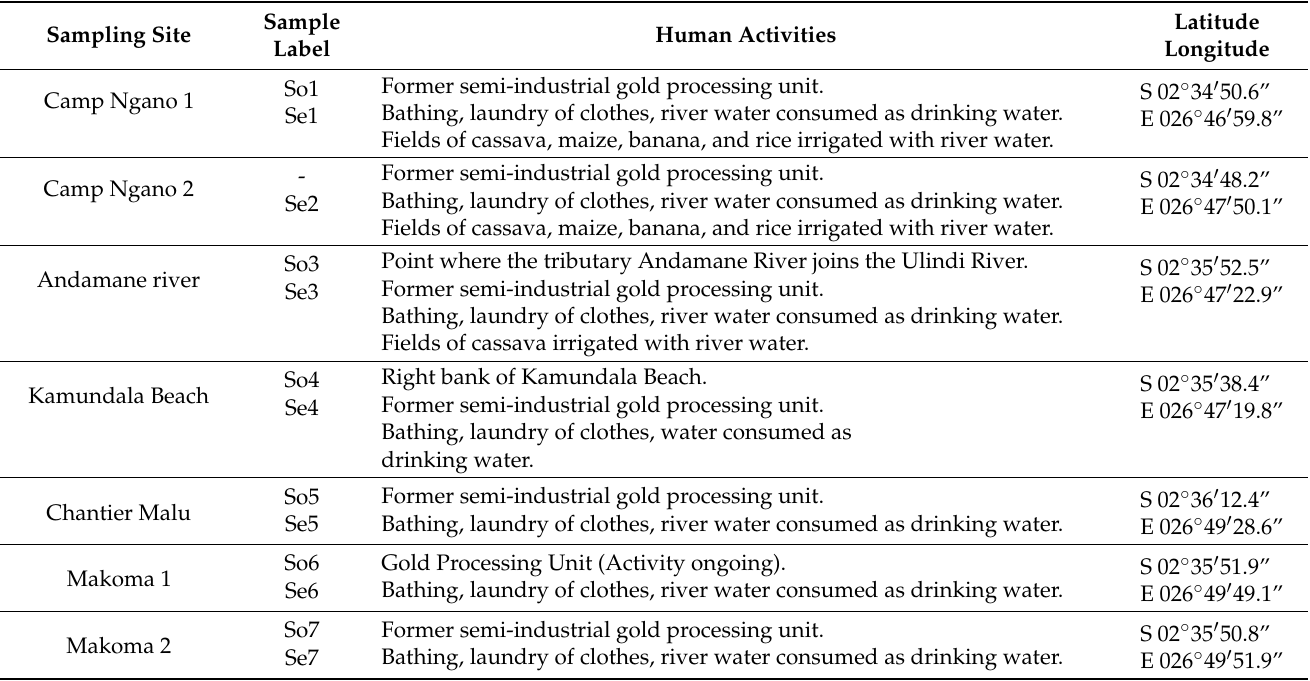
Table 1. GPS location and description of sampling